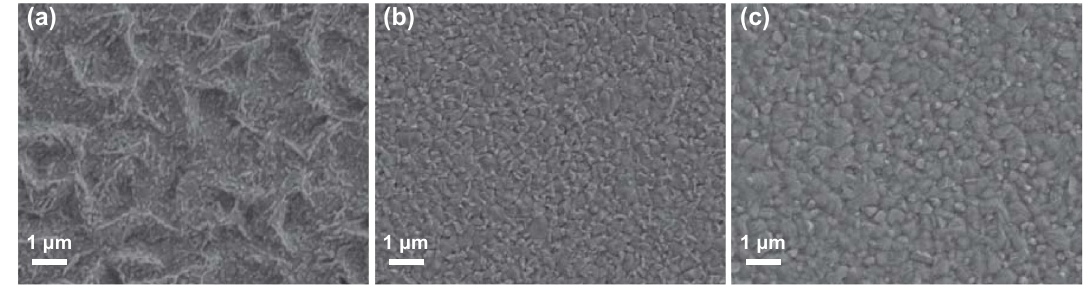
Fig. 2 a , b SEM images of perovskite films dipped in the 30 and 60 mg mL −1 FAI/MABr/MACl solution, respectively. c SEM image of perovs- kite film formed from slot-die coated FAI/MABr/MACl solution at 60 mg mL −1